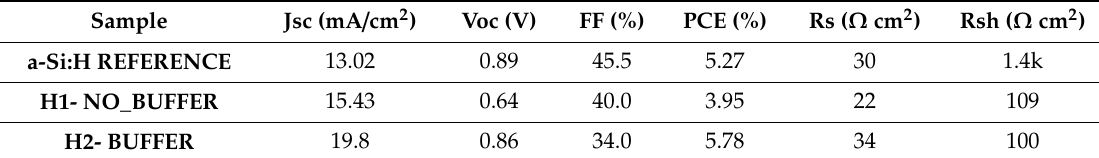
Figure 3. Performance parameters of hybrid photovoltaic structures fabricated with pristine and post-treated PEDOT:PSS films. Table 1. Performance parameters of a-Si:H reference structure and hybrid structures with and without a buffer layer.